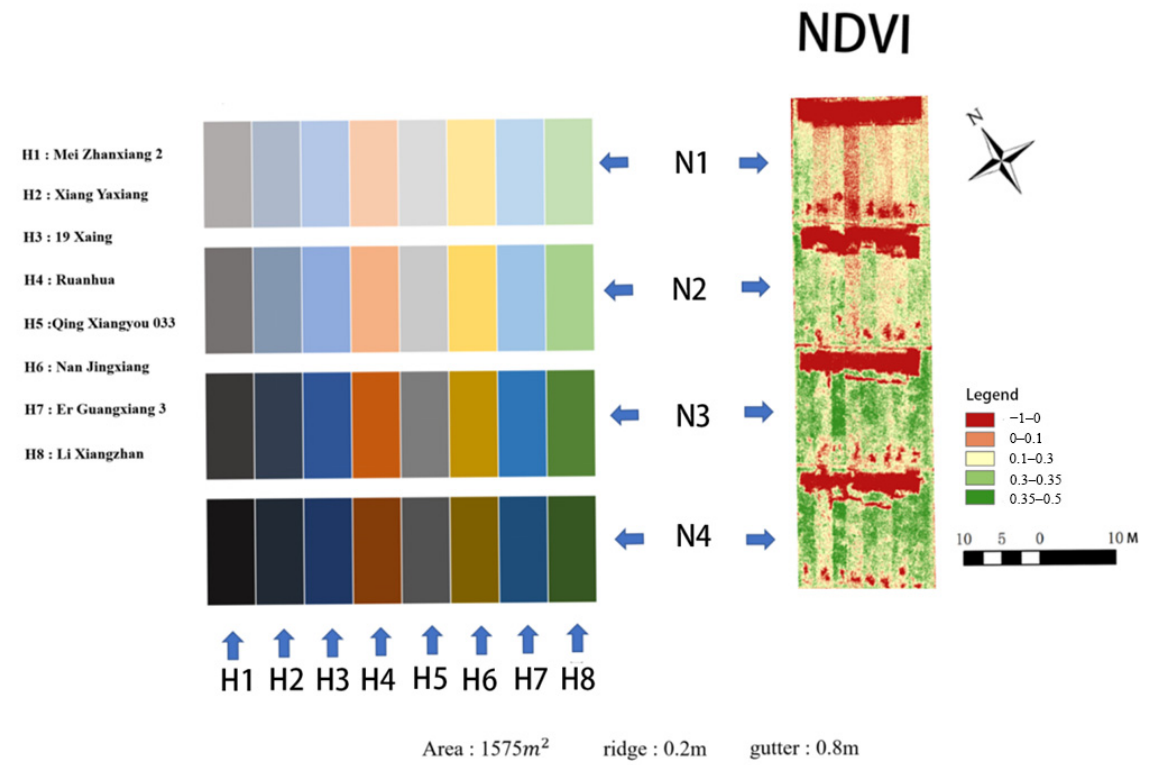
Figure 2. Experimental farm district distribution maps.